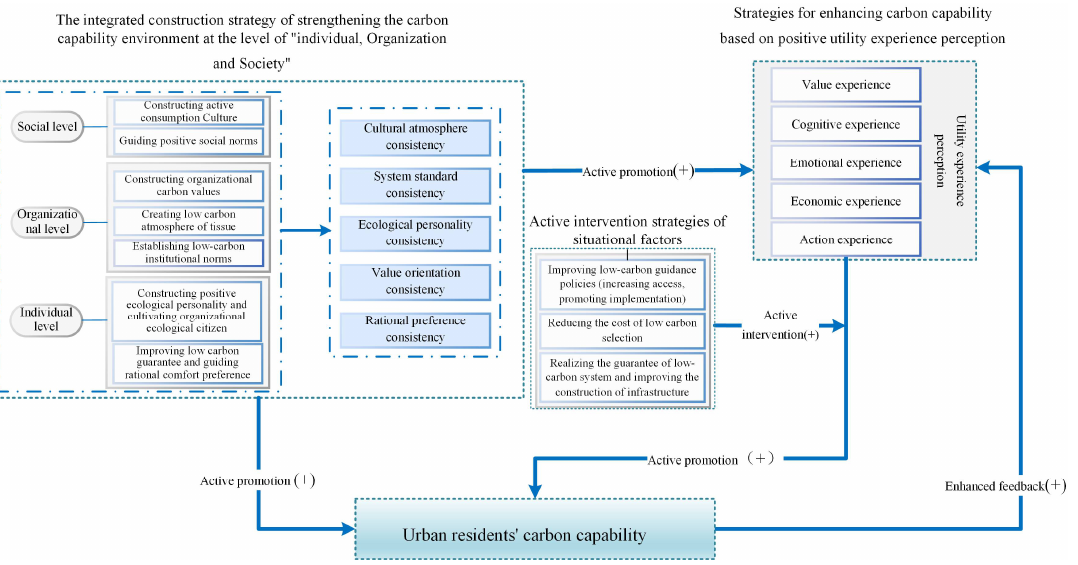
Figure 3. “Advanced cycle” for the construction of the carbon capability of urban residents, with positive utility experience perception as the core.